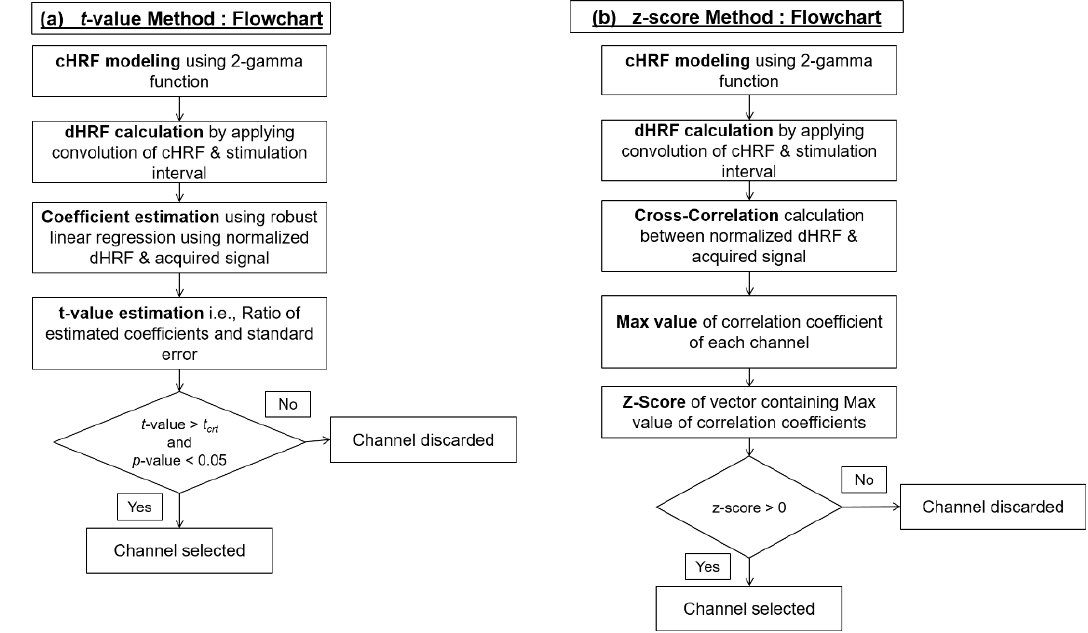
Figure 5. Step-by-step procedure of ( a ) t -value and ( b ) z-score method.